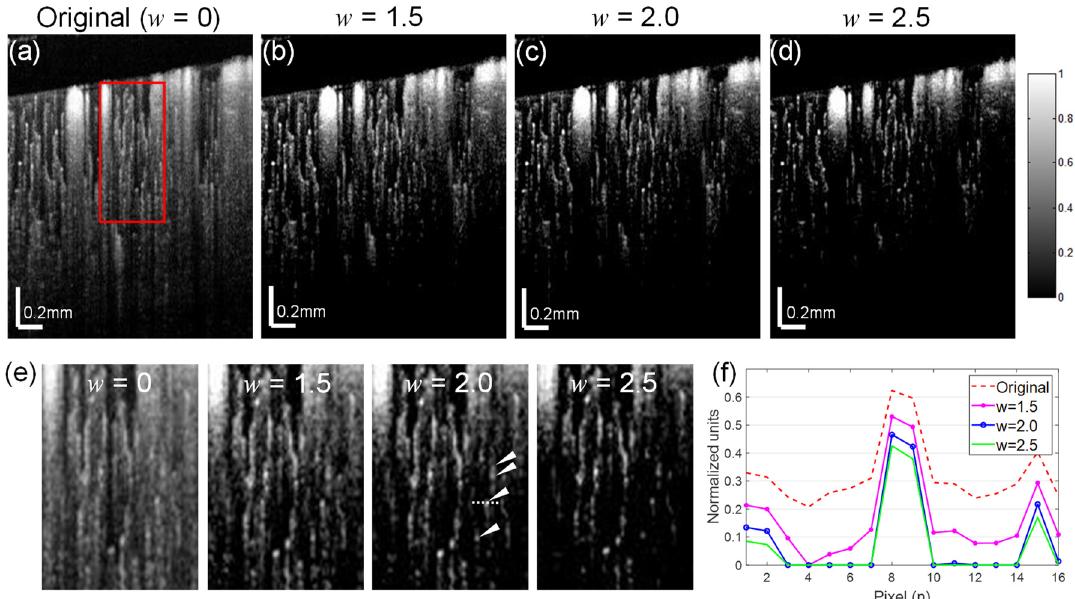
Figure 3. Comparison of de-shadowing performance using the proposed mean-subtraction method with a range of weight parameters w. ( a ) An original OCTA image of a mouse cerebral cortex and its de-shadowed images with w = 1.5 ( b ), w = 2.0 ( c ), w = 2.5 ( d ). ( e ) Enlargements of a same region (red box) in each OCTA image ( a – d ) showing de-shadowing effects, from which a series of capillaries (arrow heads) covered by the tail are seen for w = 1.5. ( f ) A graph indicating the intensity profiles taken at a section (dotted line) of the same single capillary in ( e ) showing the maximal signal-to-noise ratio near a weight of 2.0. The performance of the algorithm with a weight constant w of 1.5, 2.0, and 2.5 is shown in Figure 3b–d. The tail removal performance for each of the weight conditions (1.5–2.5) is highlighted in enlarged insets indicated by a red box in the full OCTA images in Figure 3e. The deep capillary